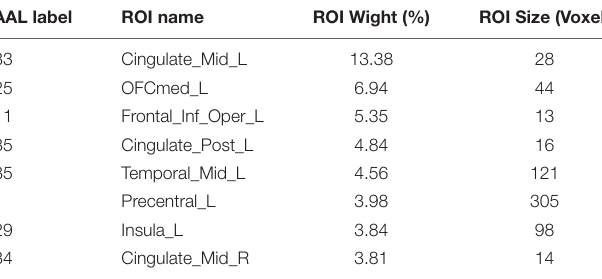
network was located in the left inferior occipital gyrus and left insula ( Table 2